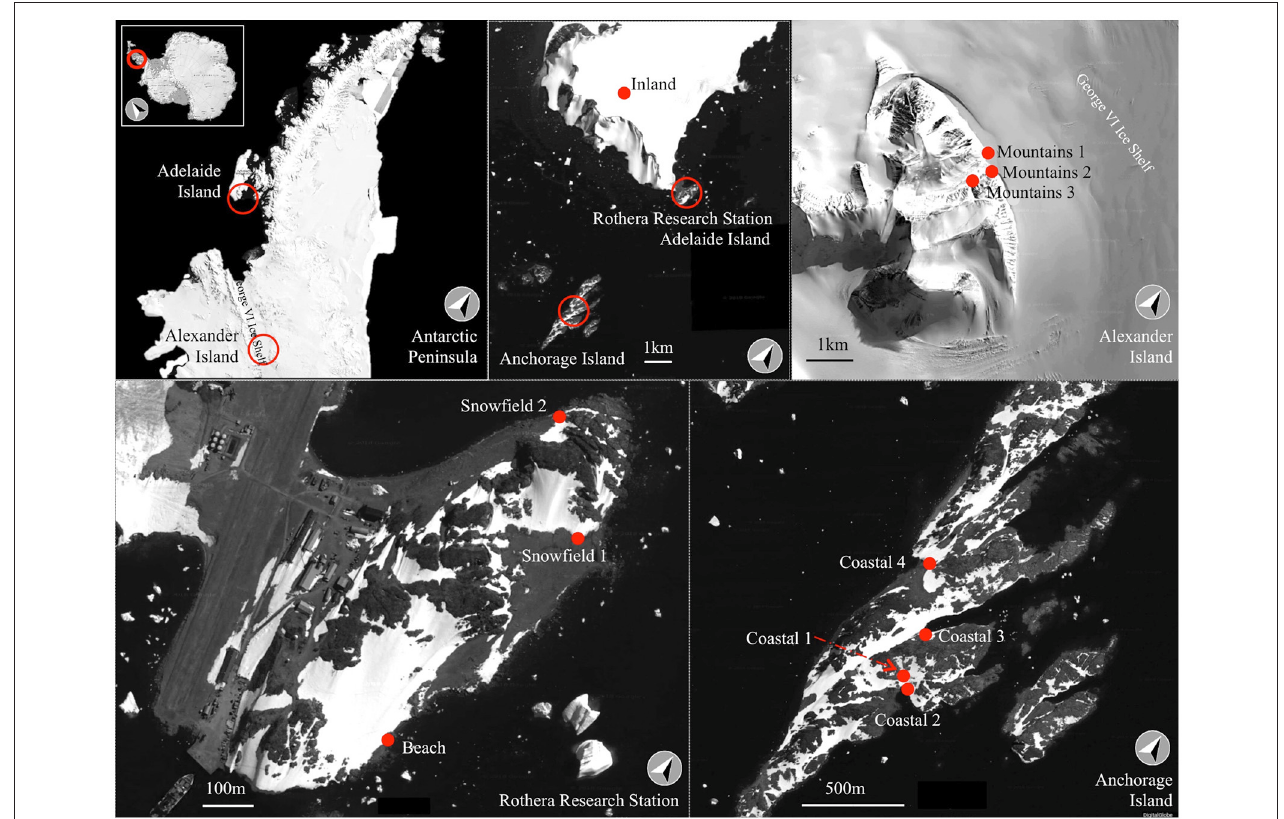
FIGURE 1 | Study location. Images modified from googlemaps.com. Imagery @2018 DigitalGlobe. Map data